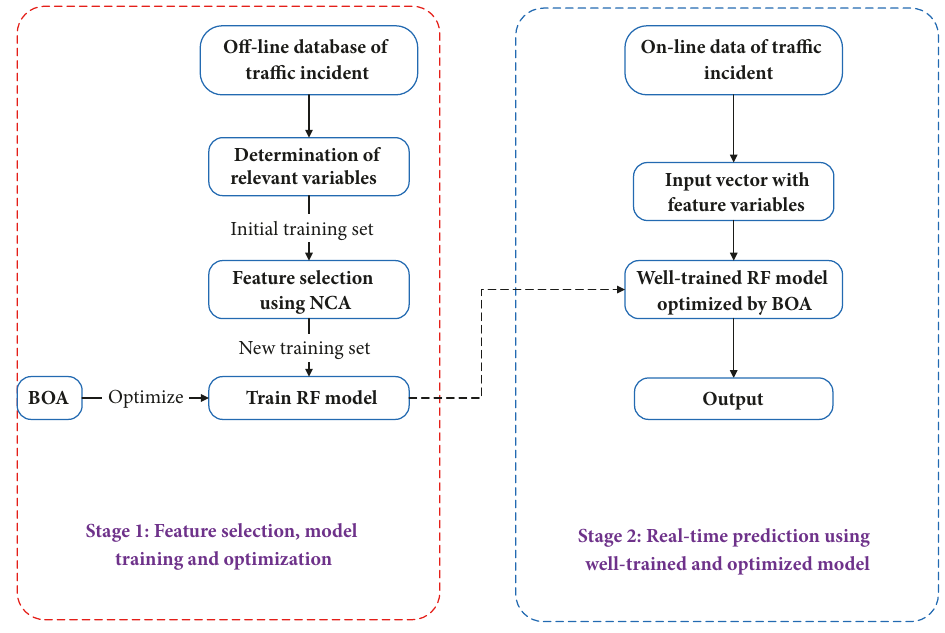
Figure 1: The flowchart of NCA-BOA-RF